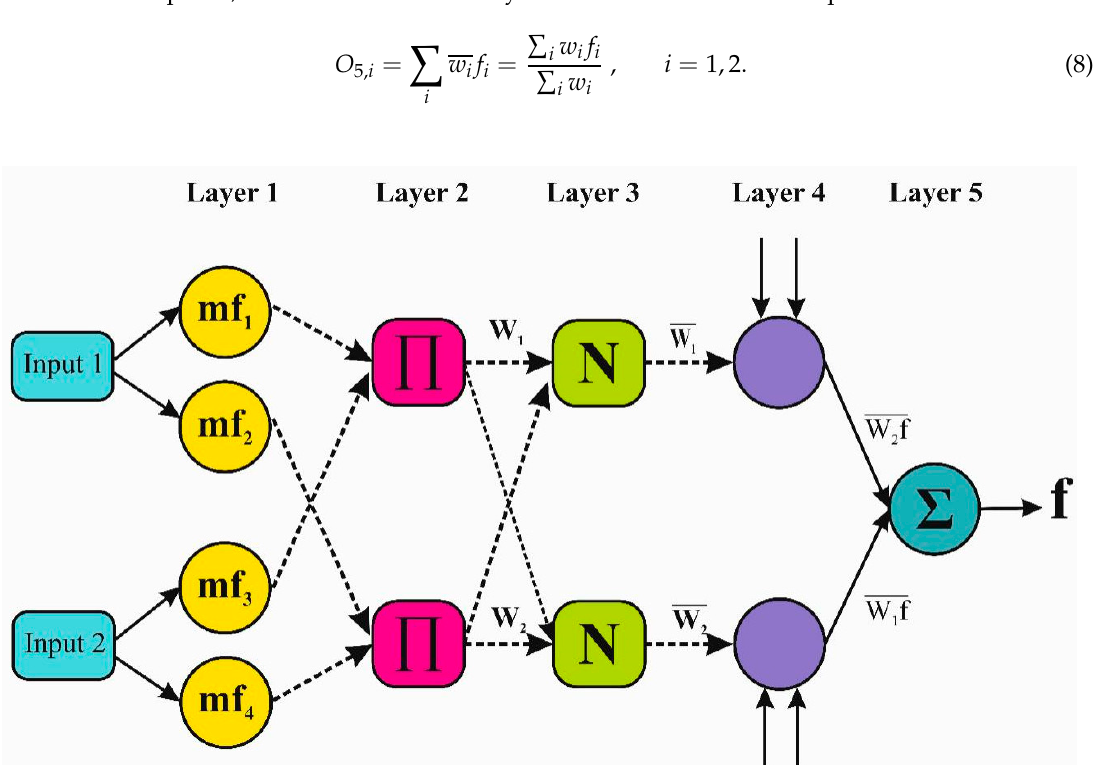
Figure 1. The structure of the adaptive neuro-fuzzy inference system model.